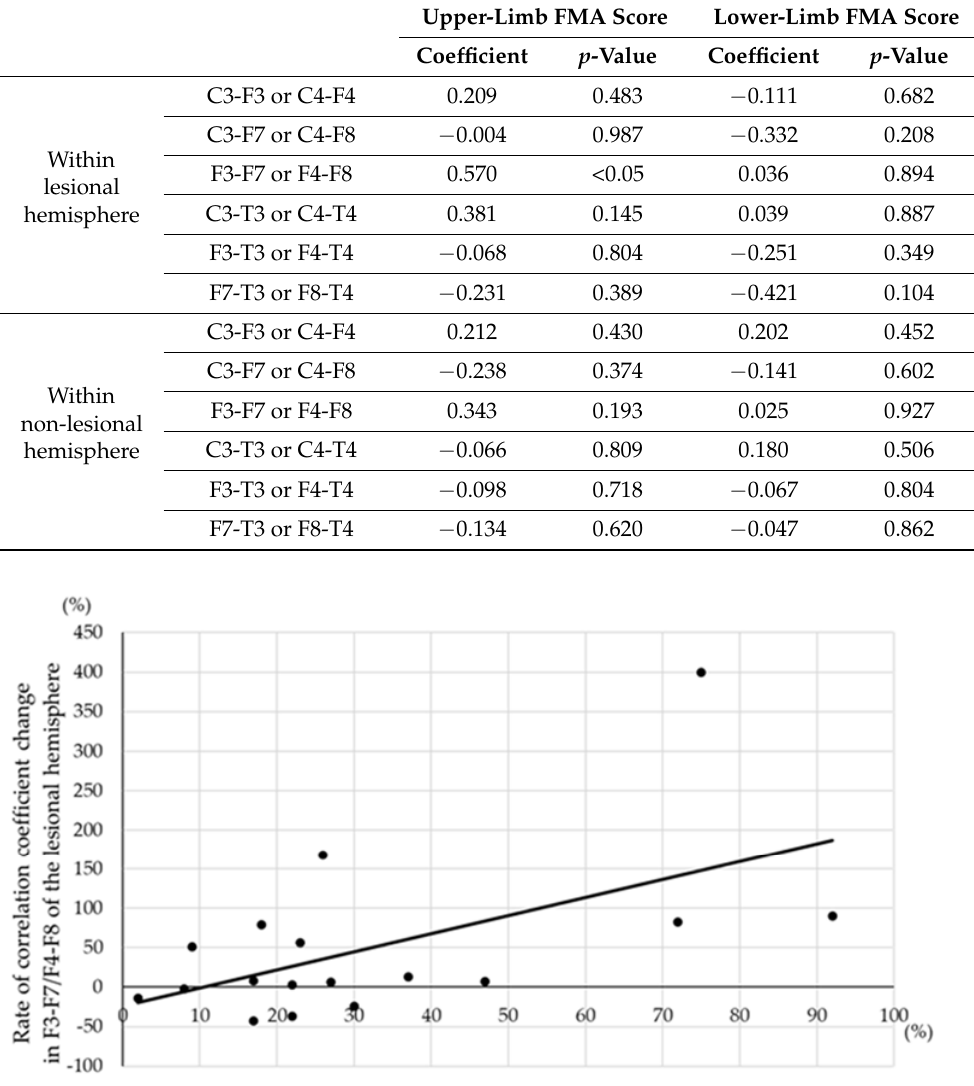
Table 4. Correlation between correlation coefficient change and FMA score change.